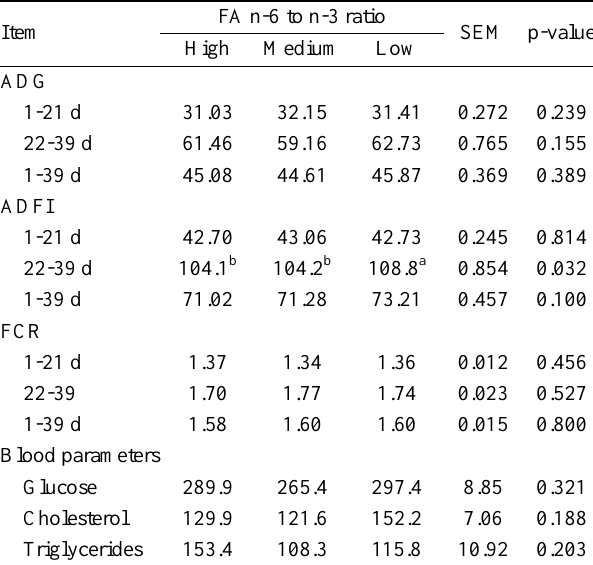
The interaction between treatment and muscle was